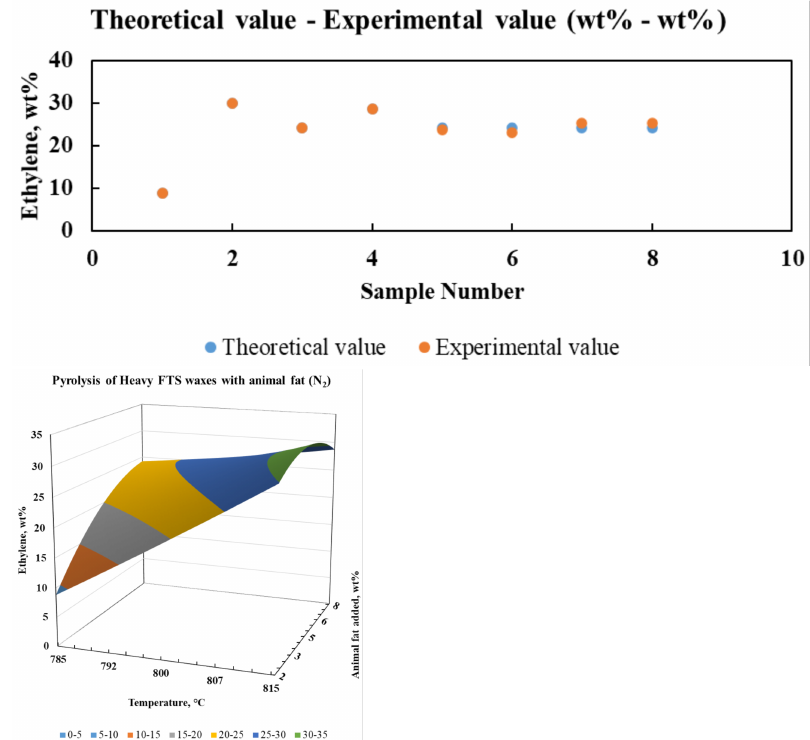
Figure 2. Theoretical and experimental difference values for the ethylene content in the product and the response surface for the tests with heavy FTS